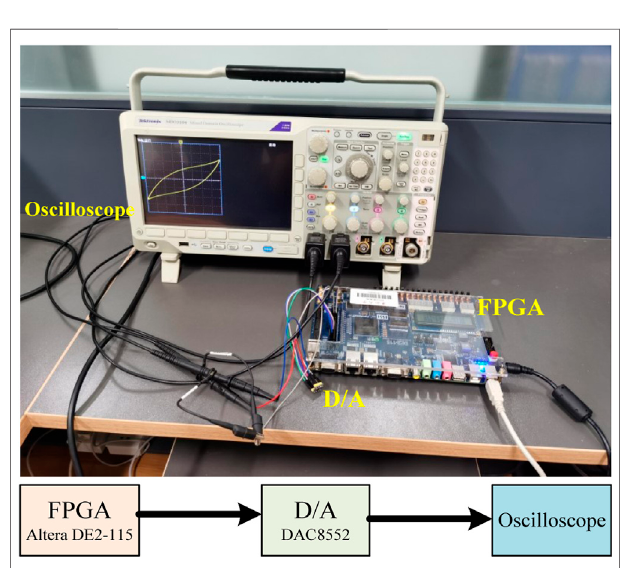
FIGURE 5 | FPGA implementation